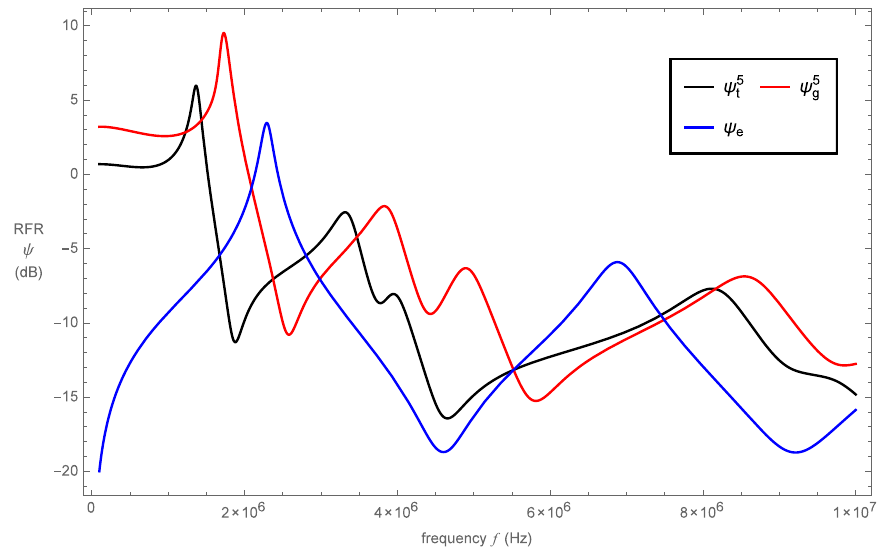
Figure 7. Non-dimensionalized RFR ψ (dB) versus frequency f (Hz) for the Sierpinski tetrix and Sierpinski gasket fractal-inspired sensors at fractal generation five and the traditional Euclidean